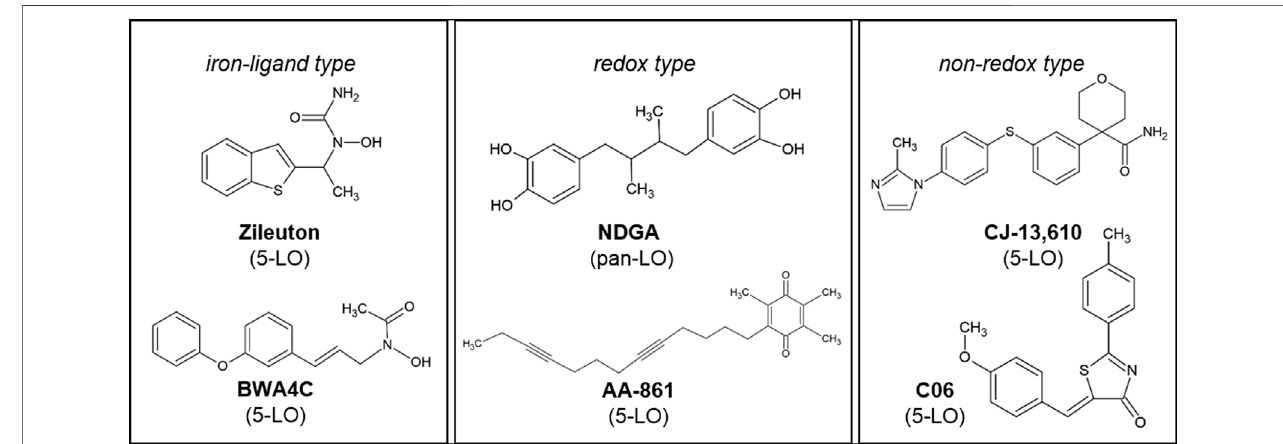
FIGURE 1 | Chemical structures of the 5-LO inhibitors. Inhibitors are grouped according to their postulated mode of action.